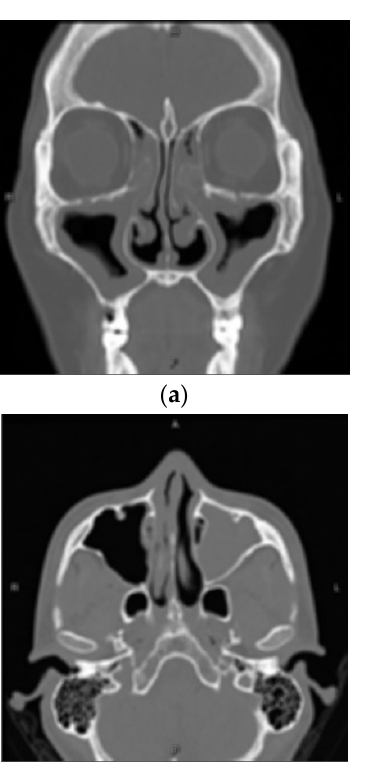
Figure 11. Resulting images after Gaussian blur. ( a ) Original image; ( b ) Gaussian blurred image; ( c ) Original image; ( d ) Gaussian blurred image.